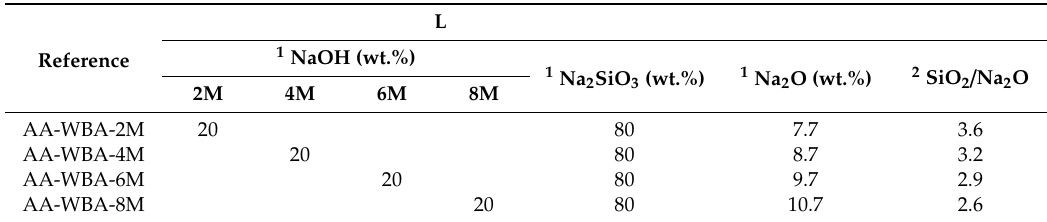
Table 2. Alkali-activator solution proportions and chemical